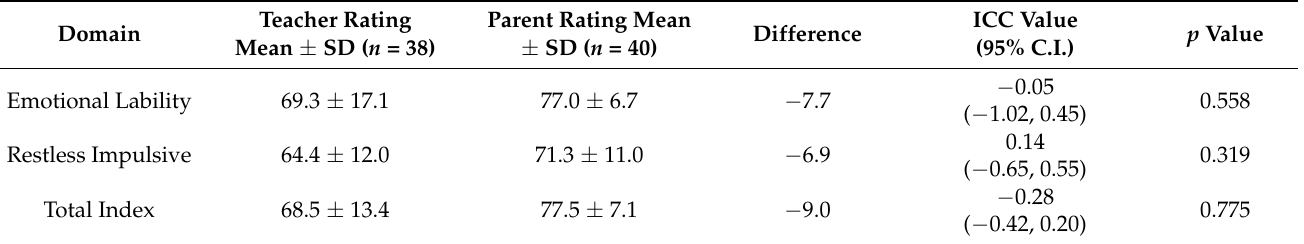
Table 3. Comparison of Conners’ Global Index—Parent version domains between ADHD and control